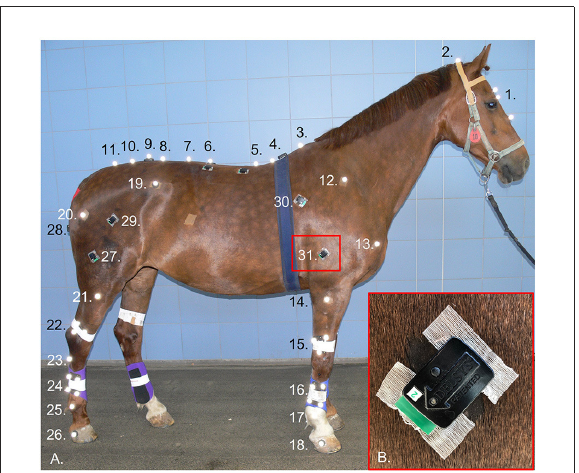
FIGURE1 Retro-reflective markers and surface electromyography (sEMG) sensors attached to one subject (A) at the following anatomical locations: 1. Marker cluster attached to head, 2. Poll, 3. T6, 4. T10, 5. T13, 6. L1, 7. L3, 8. L5, 9. Between the tubera sacrale, 10. S3, 11. S5, and bilaterally over: 12. Proximal end spina scapulae, 13. Greater tubercle of the humerus, 14. Lateral tuberosity radius, 15. Marker cluster attached to distal radius, 16. Marker cluster attached to mid 3rd metacarpal bone, 17. Center of rotation metacarpophalangeal joint, 18. Lateral hoof wall (approximately center of rotation of the distal interphalangeal joint, 19. Tuber coxae, 20. Greater trochanter of the femur, 21. Lateral tibia plateau, 22. Marker cluster attached to distal tibia, 23. Proximal end 4th metatarsal bone, 24. Marker cluster attached to mid 3rd metatarsal bone, 25. Center of rotation metatarsophalangeal joint, 26. Lateral hoof wall. Bilateral sEMG sensor sites for 27. Biceps femoris, 28. Semitendinosus, 29. Superficial gluteal, 30. Latissimus dorsi, 31. Triceps brachii. Inset (B) : showing prepared skin site and adhesion technique for sEMG